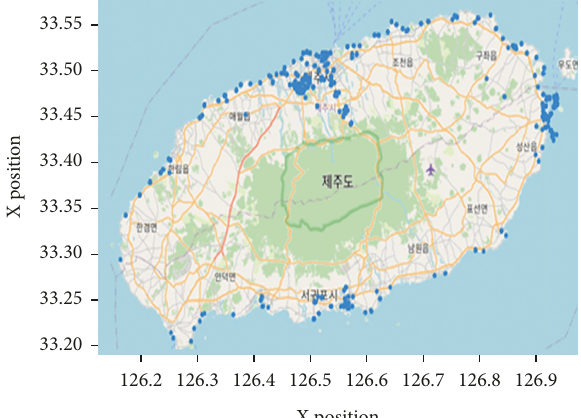
Figure 5: Rental location according to latitude and